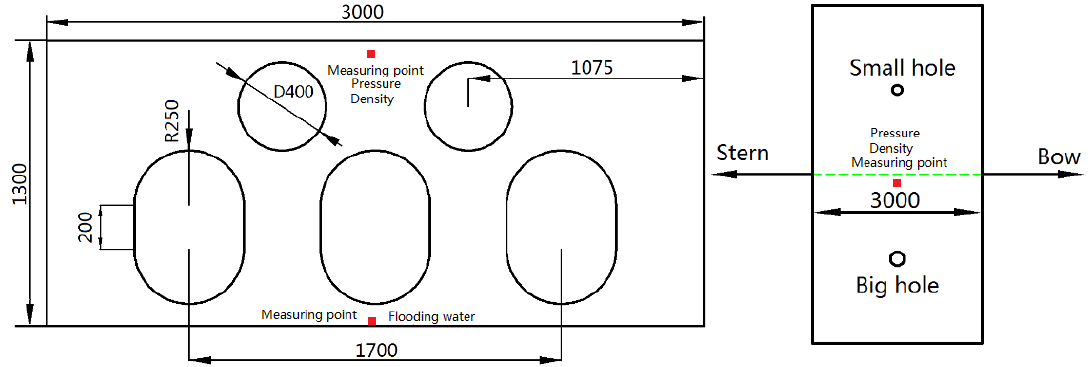
Figure 5. Sketch of the longitudinal bulkhead ( left ) and the upper deck ( right ). Table 3. Simulation cases.